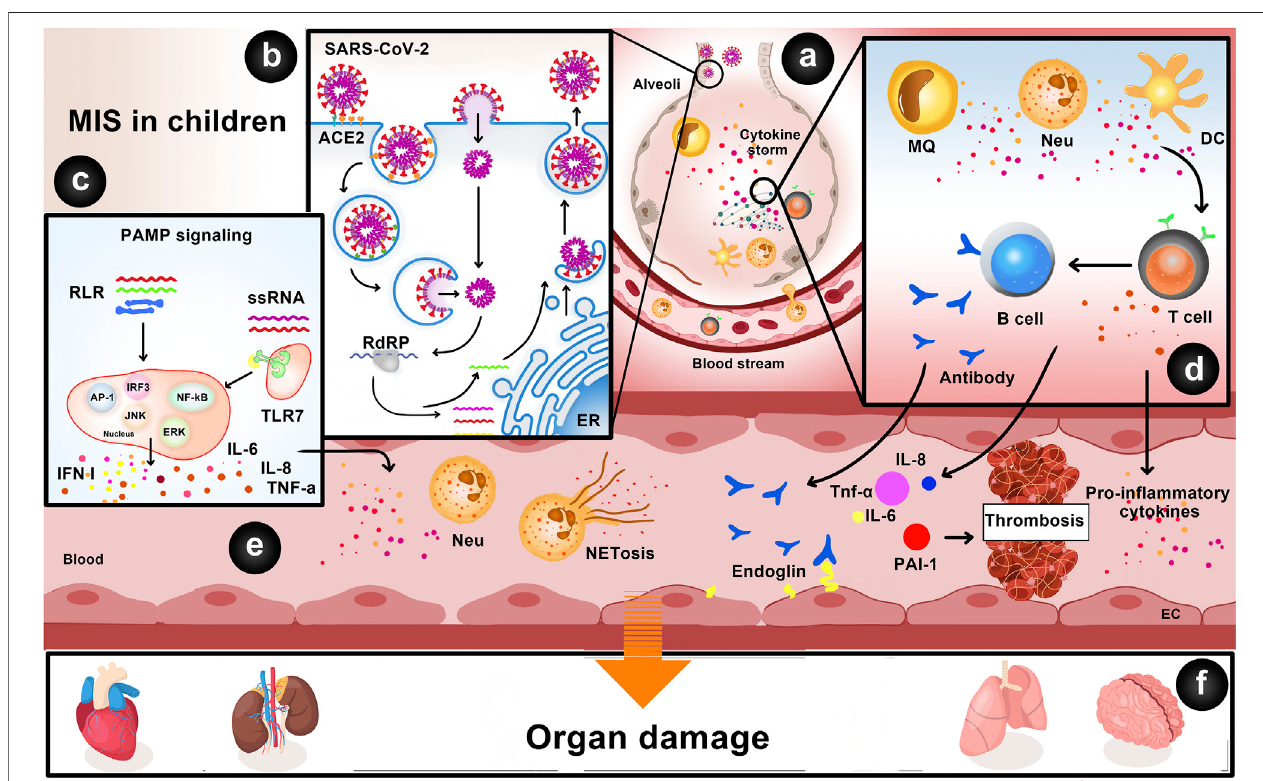
FIGURE 1 | Underlying mechanisms of multisystem in fl ammatory syndrome in children. (A,B) The binding of SARS-CoV-2 spike protein to ACE2 receptors on respiratoryepithelialcellsleadstoitscellentryandviralgenomereplicationviaRNA-dependent RNApolymerase(RdRP).Membrane-boundimmunologicreceptorsand downstreamsignaling pathways mediate thepro-in fl ammatory response resultingincytokine stormthroughthein fi ltration ofneutrophilsand macrophages intothelung tissue. (C) SARS-CoV-2viralgenomic ssRNAorotherRNAcompositionsmayactasPAMPsandbindtoTLRsandRLRs, leadingtotheactivationofIRF3,NF- κ B, MAPK/ERK, AP-1, and JNK signaling pathways and secretion of IL-6, IL-8, TNF- α , and IFN-I. (D) Cytokines produced by macrophages, neutrophils, and dendritic cells cause T cell – dependent activation of B cells and production of antibodies and autoantibodies (e.g., anti-endoglin). (E) Neutrophils can form NETs, which are released subsequenttotheruptureoftheplasmamembrane.NETs,IL-6,IL-8,TNF- α ,andPAI-1induceendothelialdamageandthrombosis. (F) Cytokinestorm,autoantibodies, andactivationofimmunecellsleadtomultipleorgandamage,includingthelungs,brain(e.g.,cellularedemaofneurons),heart(e.g.,acuteviralmyocarditis),andkidneys (e.g., acute kidney